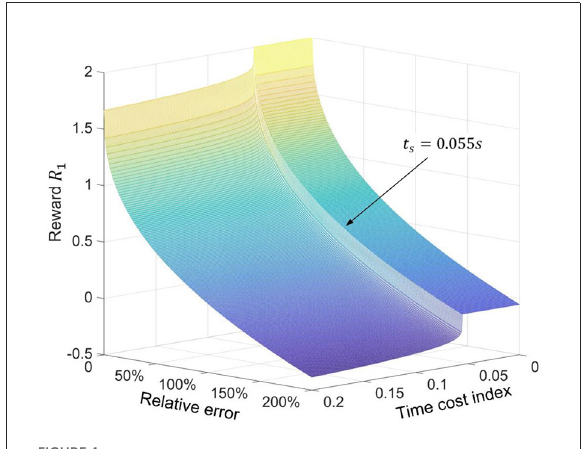
FIGURE4 Distribution of the value of the reward function R 1 on the parameter t s and parameter δ